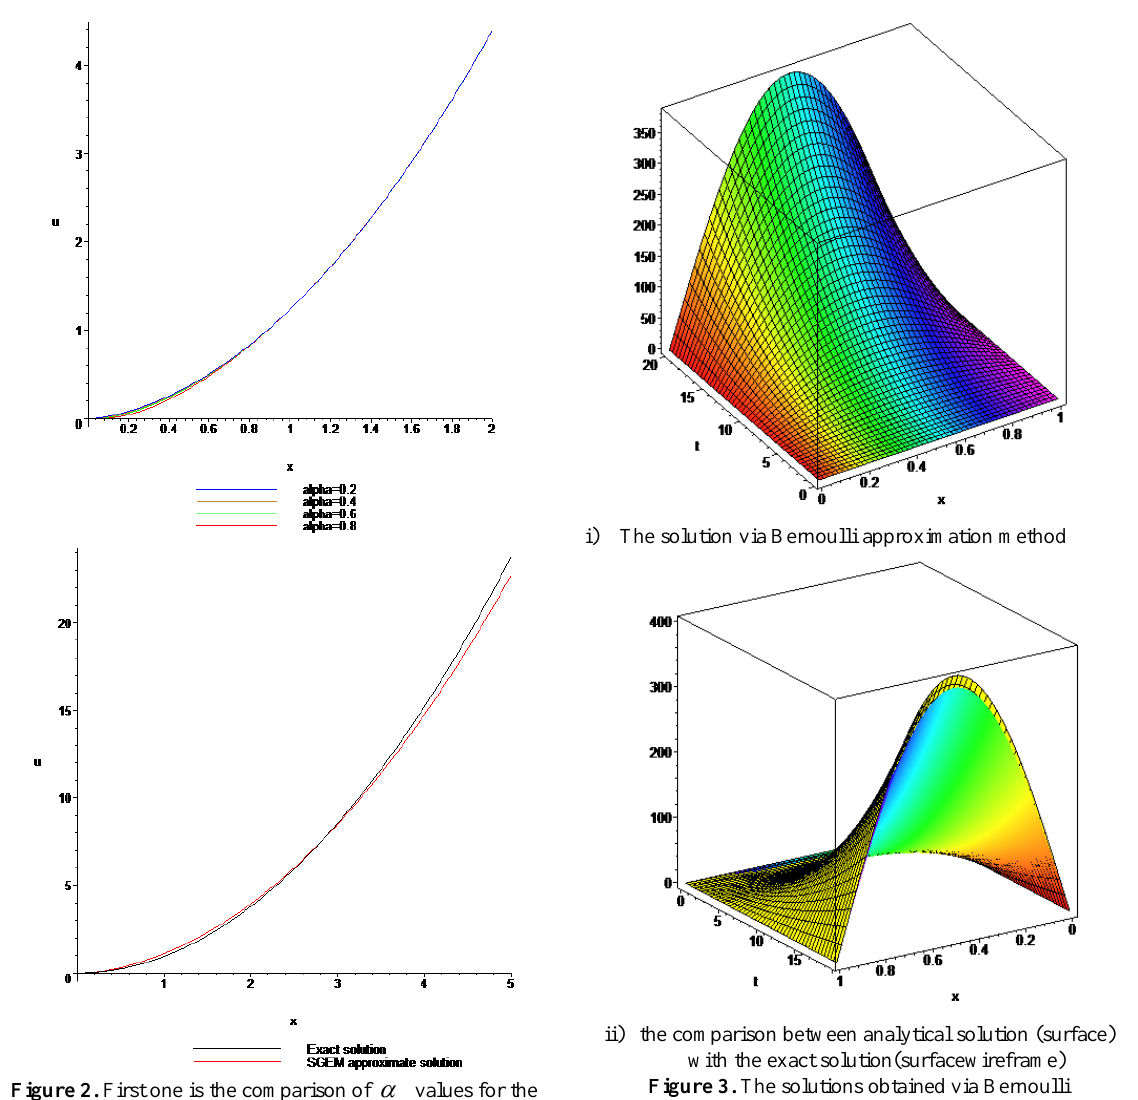
Figure 2. First one is the comparison of  values for the obtained solution; the second one is the comparison of exact solution with the analytical solution obtained via SGEM As a result, the solution of Eq. (6) with the obtained functions is